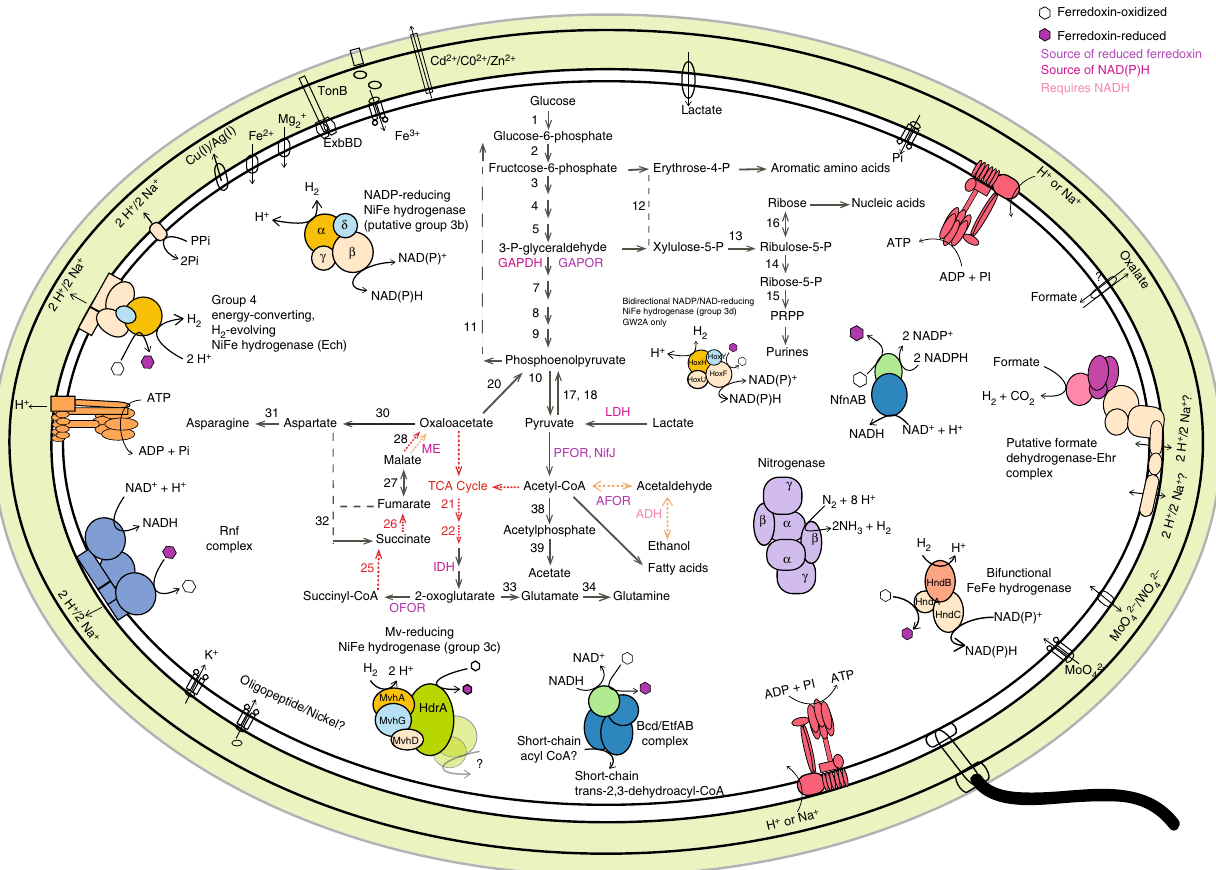
Fig. 2 Margulisbacteria RA1A cell cartoon. Key enzymes predicted to be involved in core metabolic pathways include: (1) glucokinase, (2) glucose-6- phosphate isomerase, (3) 6-phosphofructokinase 1, (4) fructose-bisphosphate aldolase class I and II, (5) triosephosphate isomerase, GAPDH glyceraldehyde 3-phosphate dehydrogenase, GAPOR glyceraldehyde-3-phosphate dehydrogenase (ferredoxin), (7) phosphoglycerate kinase, (8) phosphoglycerate mutase 2,3-bisphosphoglycerate-dependent and 2,3-bisphosphoglycerate-independent, (9) enolase, (10) pyruvate kinase, (11) fructose- 1,6-bisphosphatase III, (12) transketolase, (13) ribulose-phosphate 3-epimerase, (14) ribose 5-phosphate isomerase B, (15) ribose-phosphate pyrophosphokinase, (16) ribokinase, (17) pyruvate, orthophosphate dikinase, (18) pyruvate water dikinase, LDH: lactate dehydrogenase, (20) phosphoenolpyruvate carboxykinase (ATP), (21) citrate synthase, (22) aconitate hydratase, IDH isocitrate dehydrogenase, OFOR 2-oxoglutarate ferredoxin oxidoreductase, (25) succinyl-CoA synthetase, (26) succinate dehydrogenase, (27) fumarate hydratase, (28) malate dehydrogenase, ME malic enzyme (oxaloacetate-decarboxylating), (30) aspartate transaminase, (31) asparagine synthetase, (32) L -aspartate oxidase, (33) glutamate synthase,